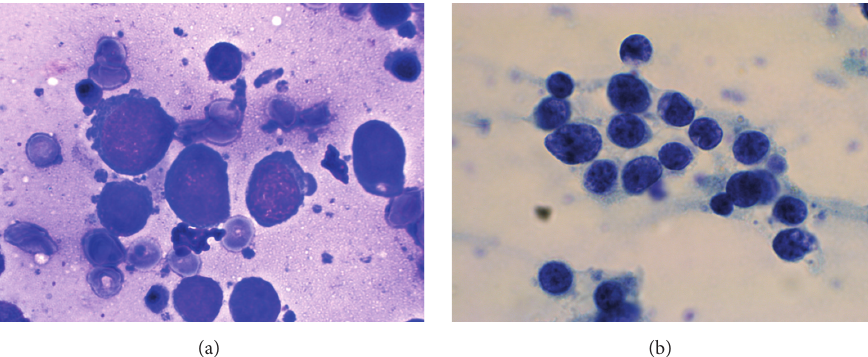
Figure 2: Diff-Quik (a) and Papanicolaou (b) stained smears from the FNA of the left lateral triceps mass show predominantly larger cells with occasional